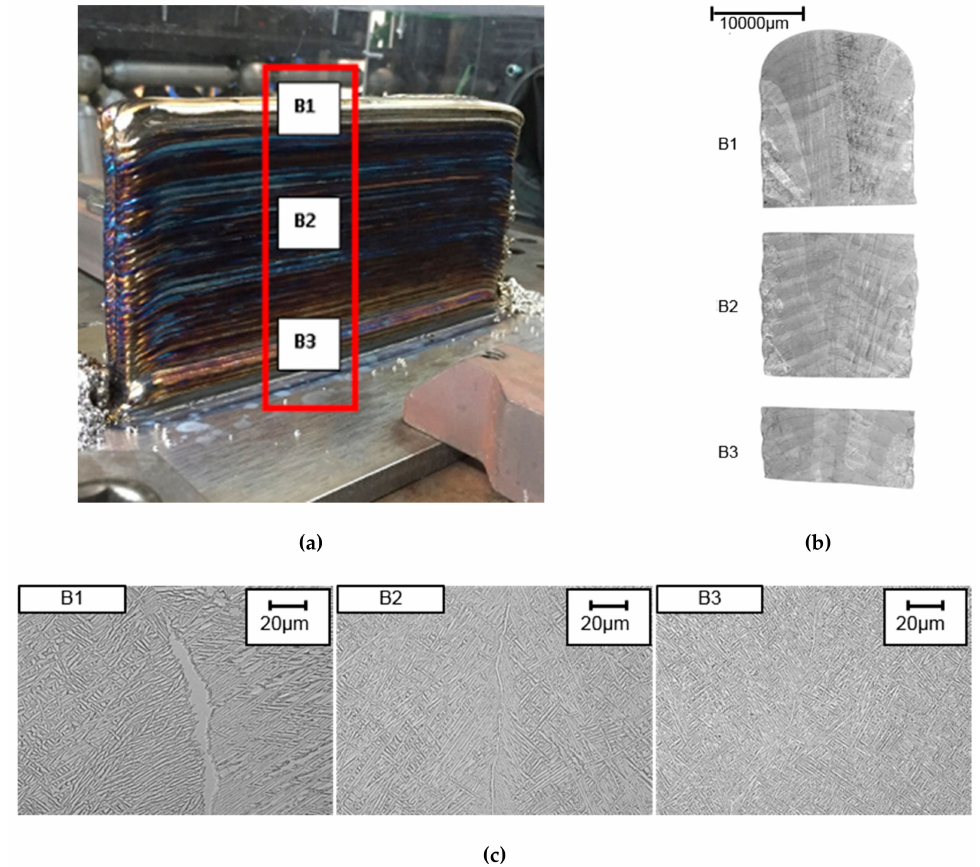
Figure 6. Grain structure of the wall manufactured by plasma arc welding (PAW)-WAAM ( a ) at di ff erent heights and ( b ) from the top to bottom, as well as ( c ) micrographic pictures at di ff erent heights at 500X